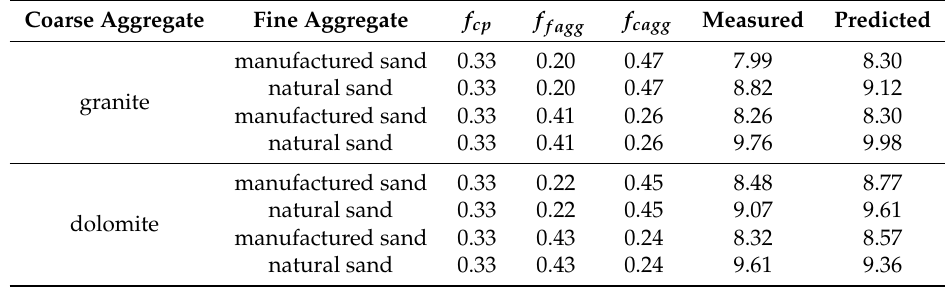
Table 6. Comparison of the model predicted with the experimentally measured thermal expansion coefficients by Tasneem et al. [3] for concretes with different volumetric compositions (unit: 10 − 6 / ◦ C). Coarse